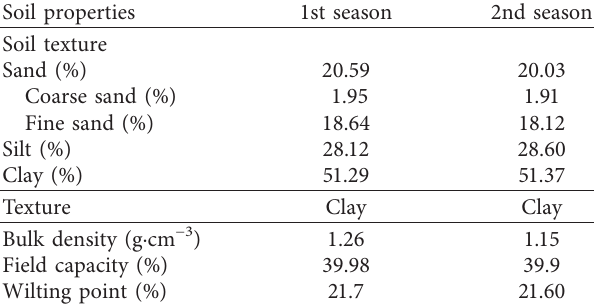
Table 1: Physical analysis of soil experimental